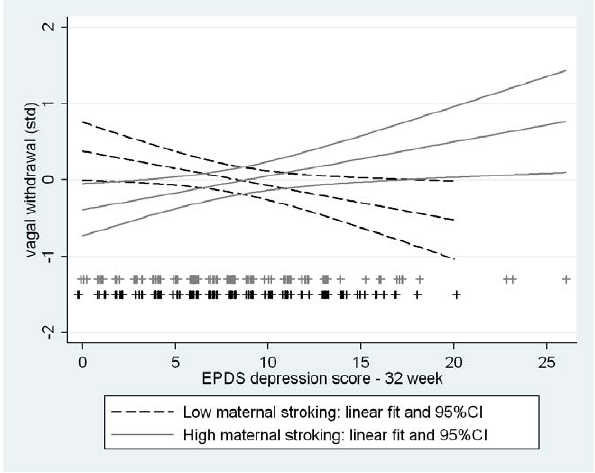
Figure 4. Interaction between maternal stroking and prenatal depression on infant vagal withdrawal. Simple regression lines and 95% confidence envelopes showing the interaction between maternal reports of stroking (median split) and prenatal depression, with infant vagal withdrawal at 29 weeks (p=0.01 from multivariate